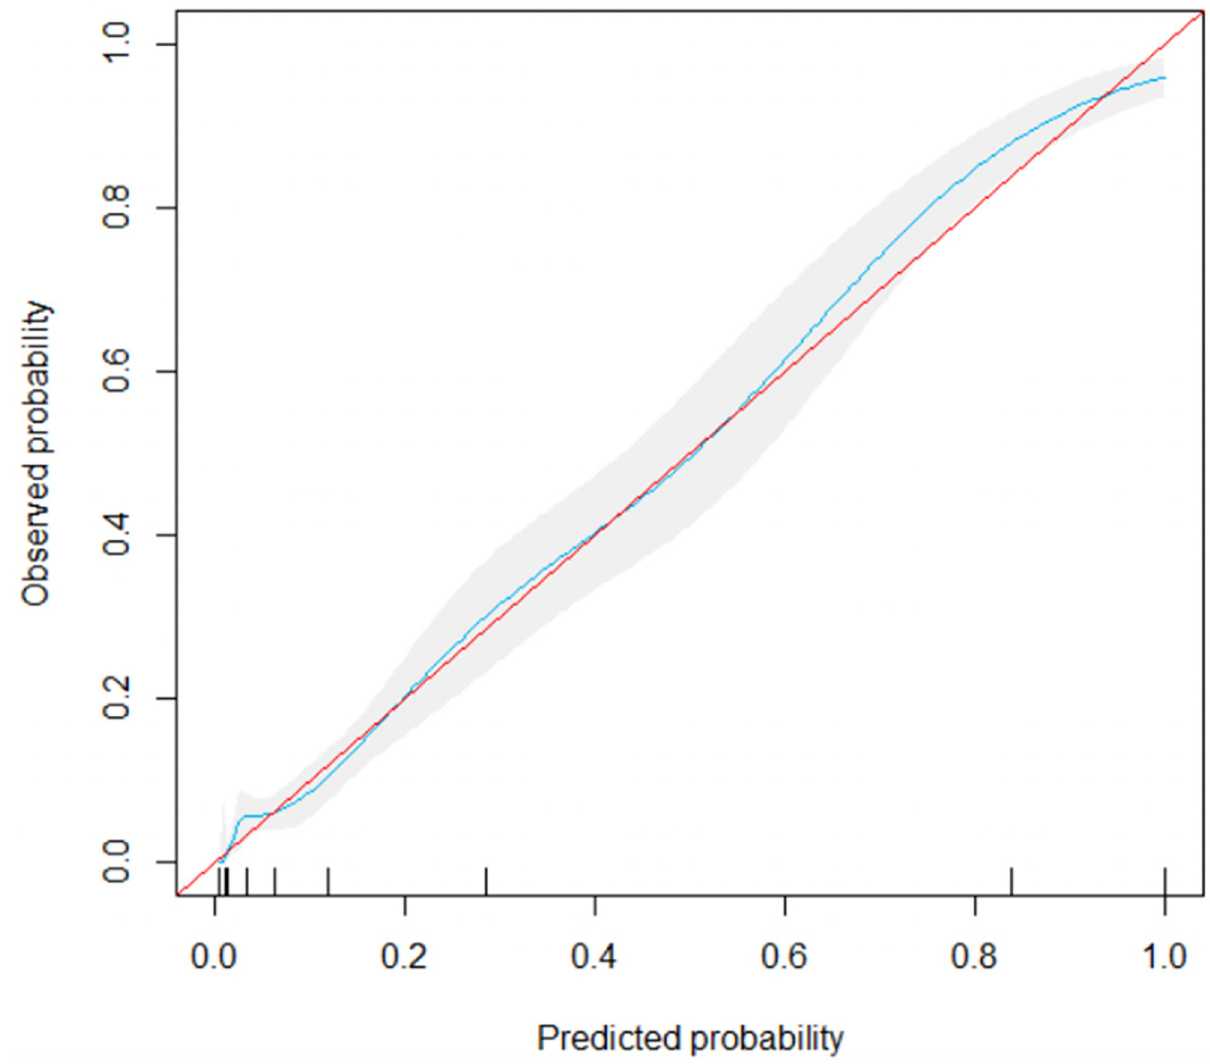
Fig 3. Calibration curve comparing the probability of mortality predicted by the score and the probability of mortality observed in the patient population in the test set of data (slope = 1 and Brier score = 0.061).